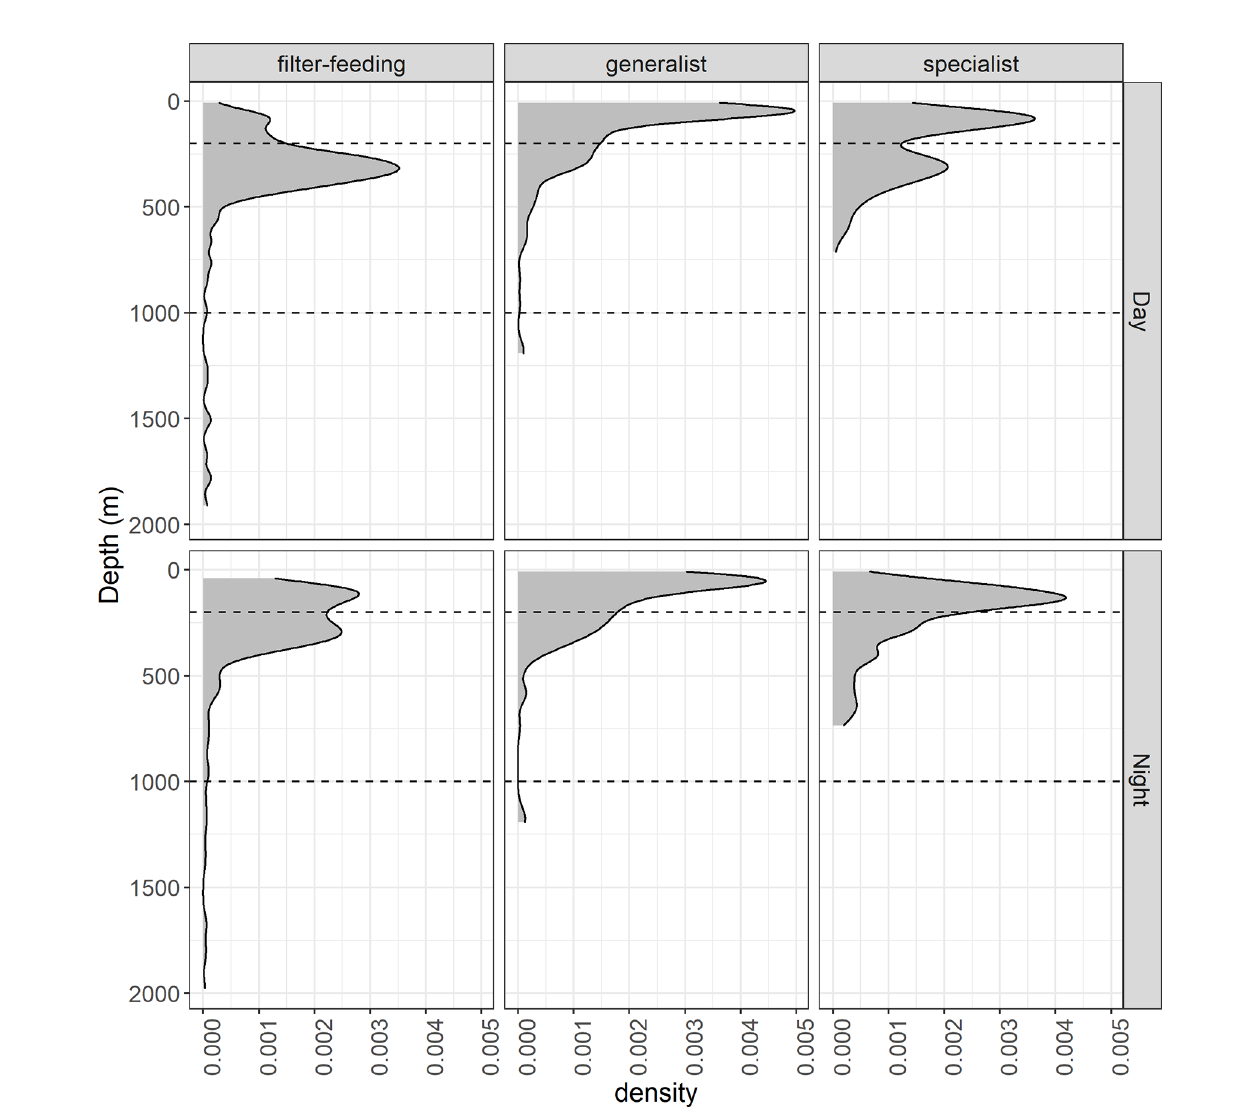
FIGURE 2 | Density plot of the smoothed distribution of pelagic elasmobranch maximum diving depths ( maxDepth , in meters) grouped by species feeding habit for each diel phase. The upper and lower horizontal dashed lines depict the 200- and 1000-m isobaths,